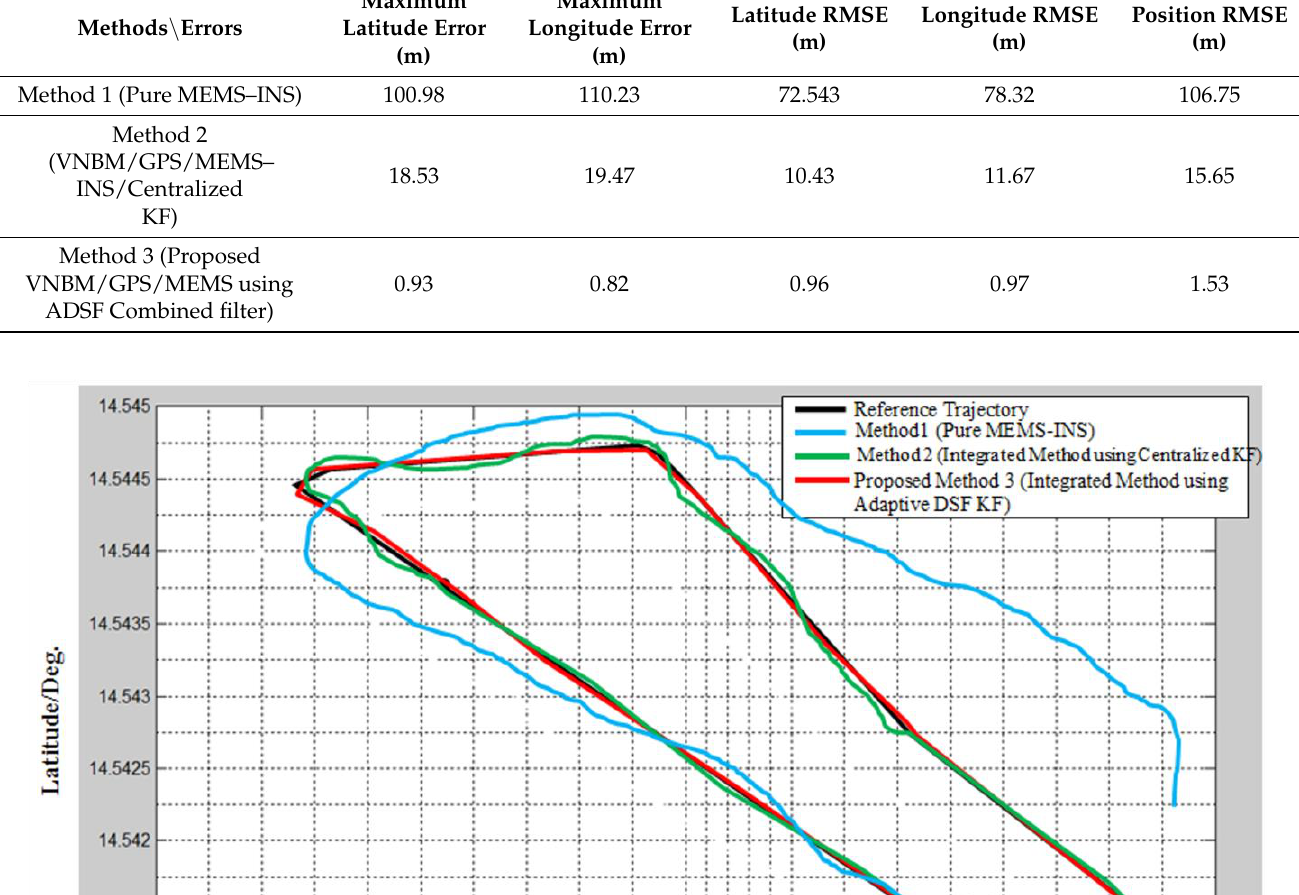
Figure 10. Reference Trajectory and Reference Landmarks.